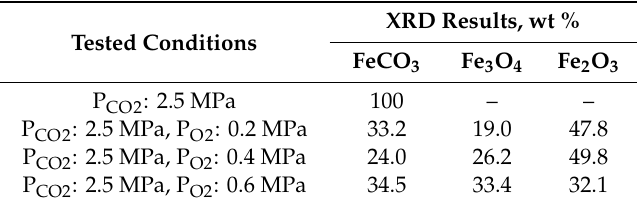
Figure 7. XRD analysis of erosion-corrosion products of 3Cr steel under di ff erent conditions ( a ) P CO2 : 2.5 MPa, ( b ) P CO2 : 2.5 MPa, P O2 : 0.2 MPa, ( c ) P CO2 : 2.5 MPa, P O2 : 0.4 MPa, ( d ) P CO2 : 2.5 MPa, P O2 : 0.6 MPa. Table 4. XRD semiquantitative calculation data of erosion-corrosion scales of tested steels in di ff erent